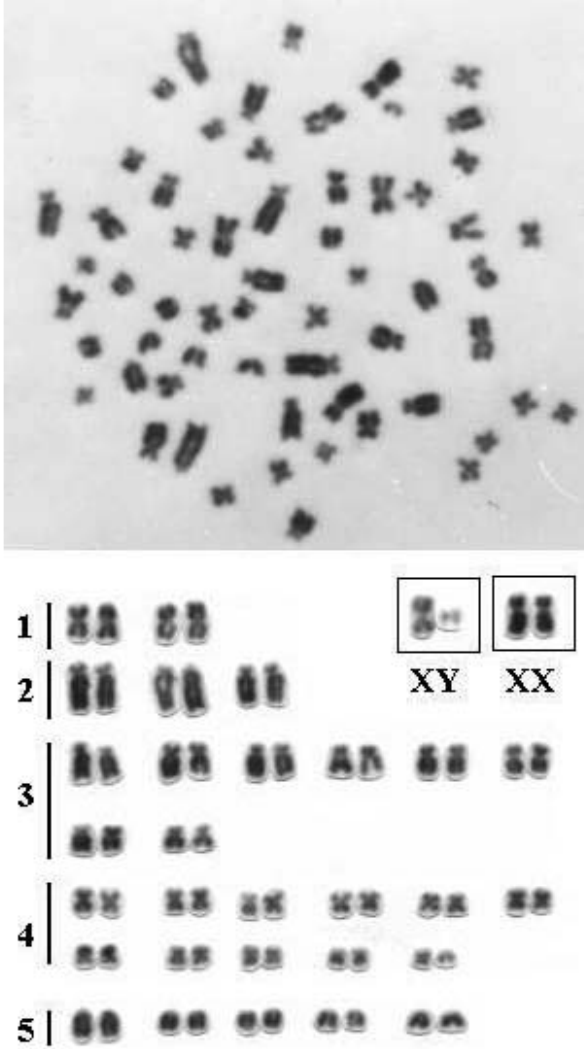
Figure1 - Karyotypeof Tamanduasp .with2n=56chromosomes.TheX chromosome is a large metacentric, and the Y chromosome is a small